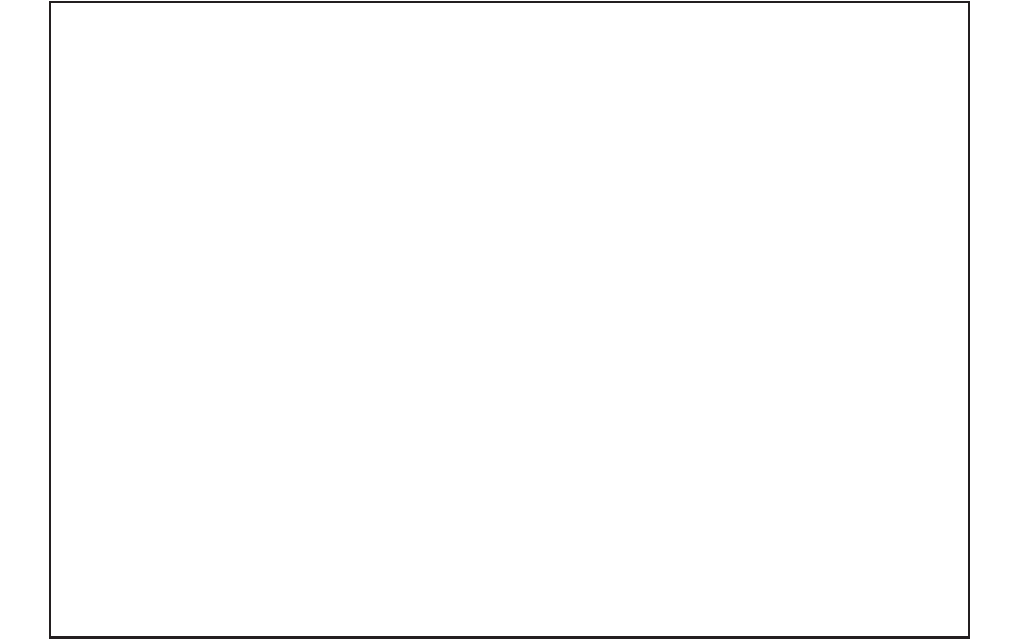
Fig. 1: Photograph of atlas vertebra (superior view) showing - 1. Spicules, 2. Superior articular facets 3. Additional facets, 4. Foramen transversarium, 5. Posterior tubercle, 6. Single additional